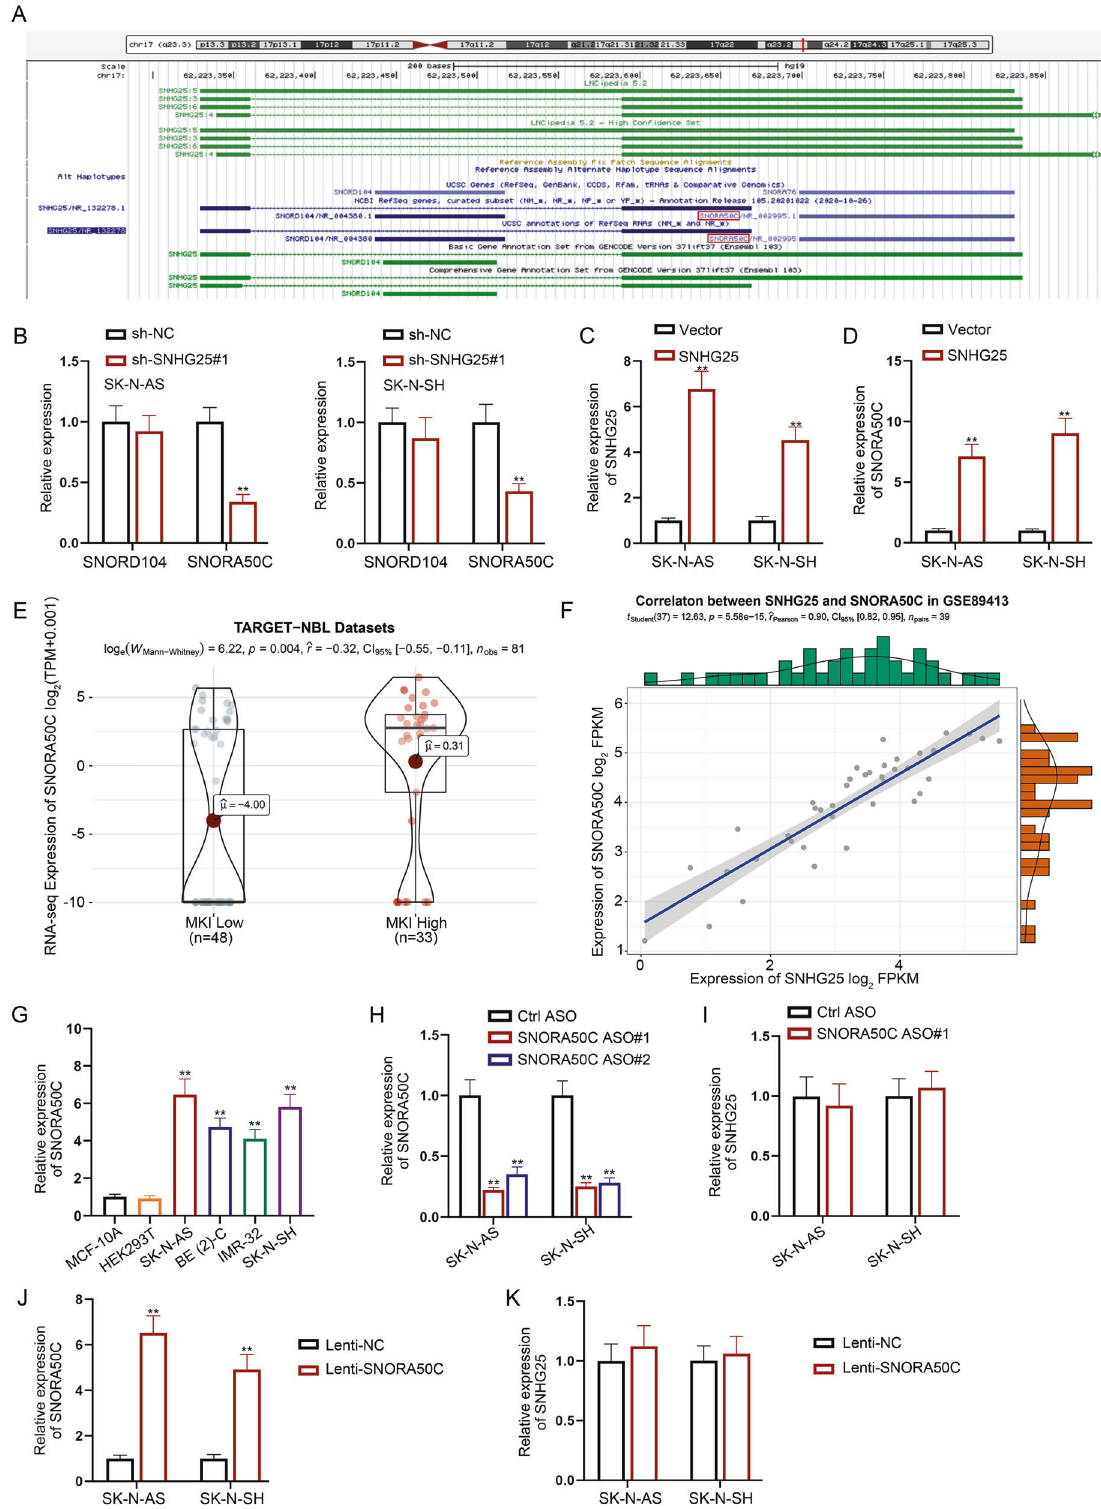
supplementary data). Moreover, we found that SNHG25 de fi ciency signi fi cantly weakened the binding of DKC1 with other snoRNP- related proteins (Fig. 5G, original blots were shown in supple- mentary data). In sum, SNHG25 recruits DKC1 to stabilize SNORA50C through facilitating snoRNP